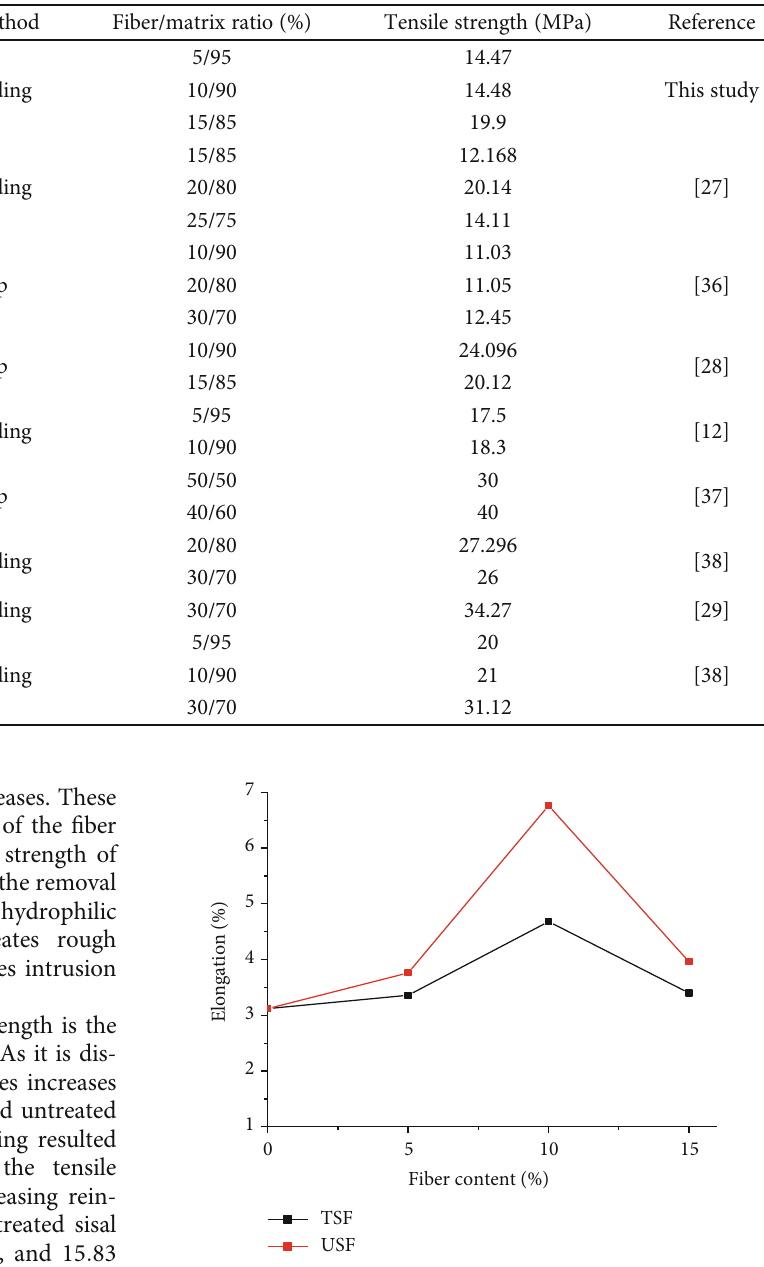
Table 2: Comparison with previous works on tensile properties of natural fi ber composites.